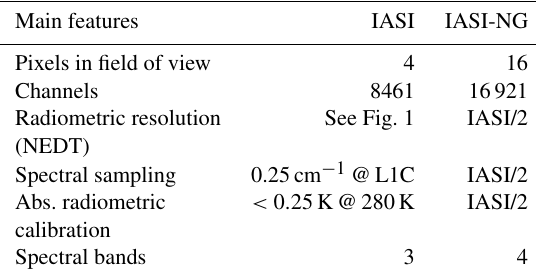
Figure 1. NEDT noise at 280K for IASI and IASI-NG (source data from E. Pequignot, CNES). Table 1. Main features of IASI and IASI-NG